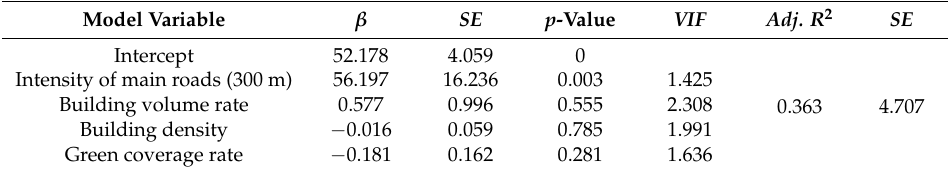
Table 6. Multiple linear regression model for annual PM 2.5 concentrations in residential